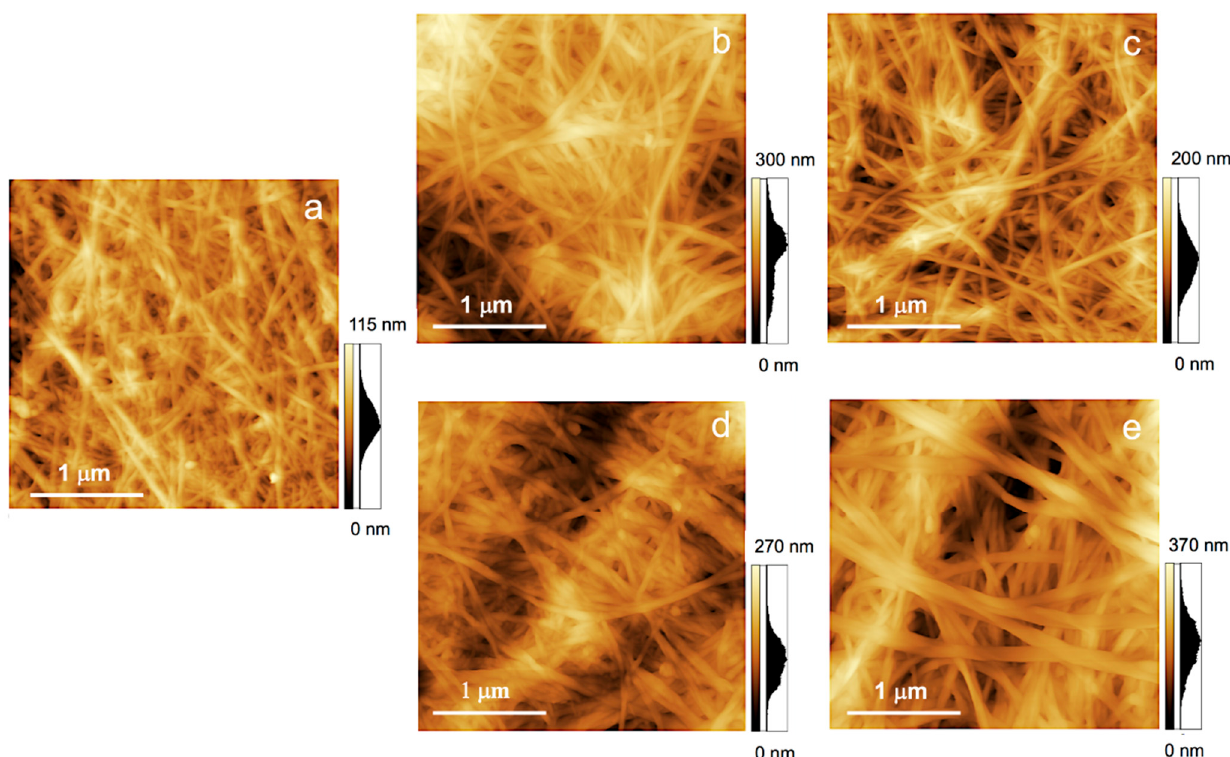
Figure 5. Surface topography of the initial BC ( a ), BC after AA/ImCl ( b ), after AA/ChCl ( c ), BC-PAA from AA/ImCl ( d ) and from AA/ChCl ( e ).